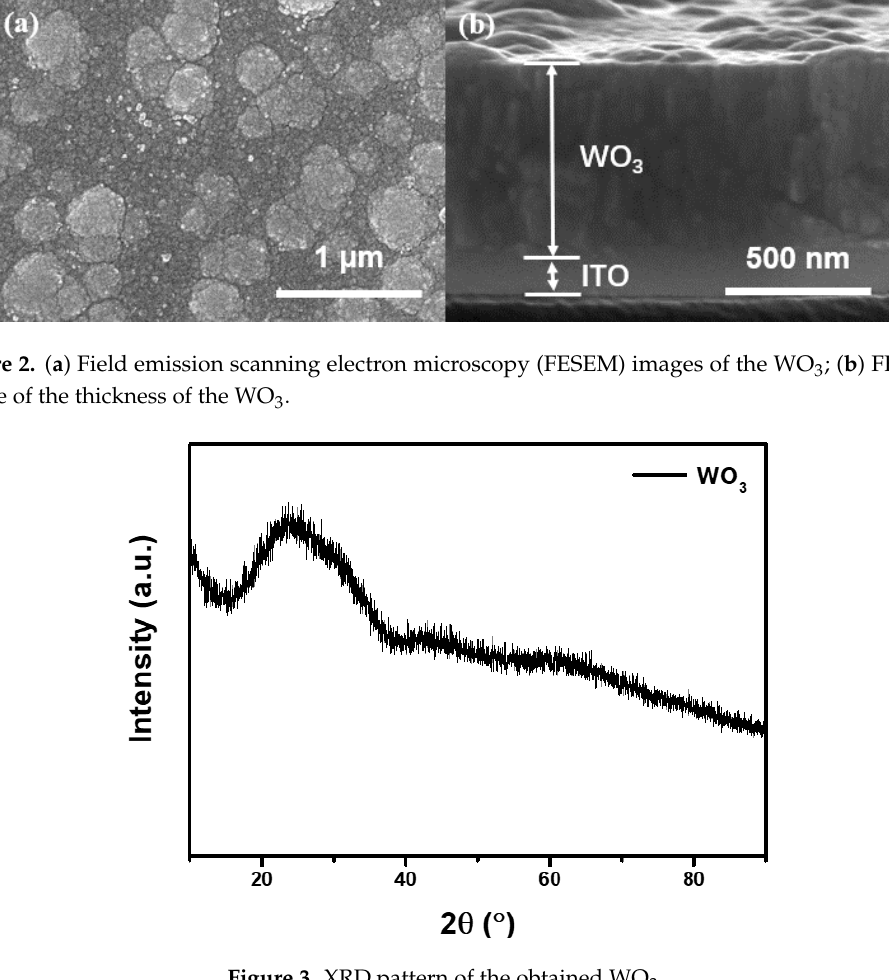
Figure 3. XRD pattern of the obtained WO 3 .